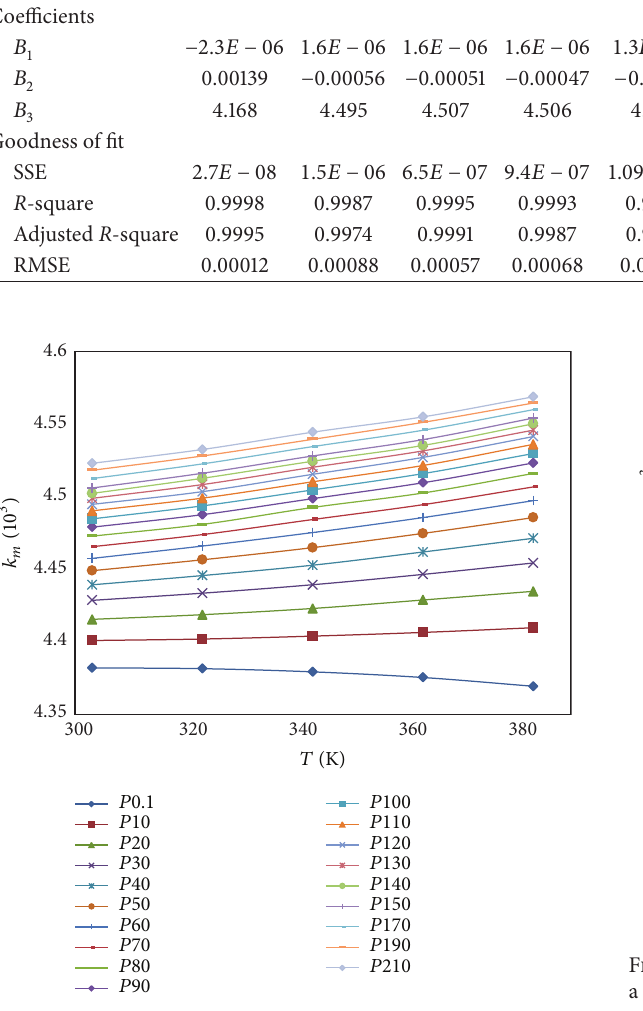
Figure 3: Molecular compressibility of methyl caprate (MeC10:0) as a function of temperature along various isobaric (only calculated values were revealed).